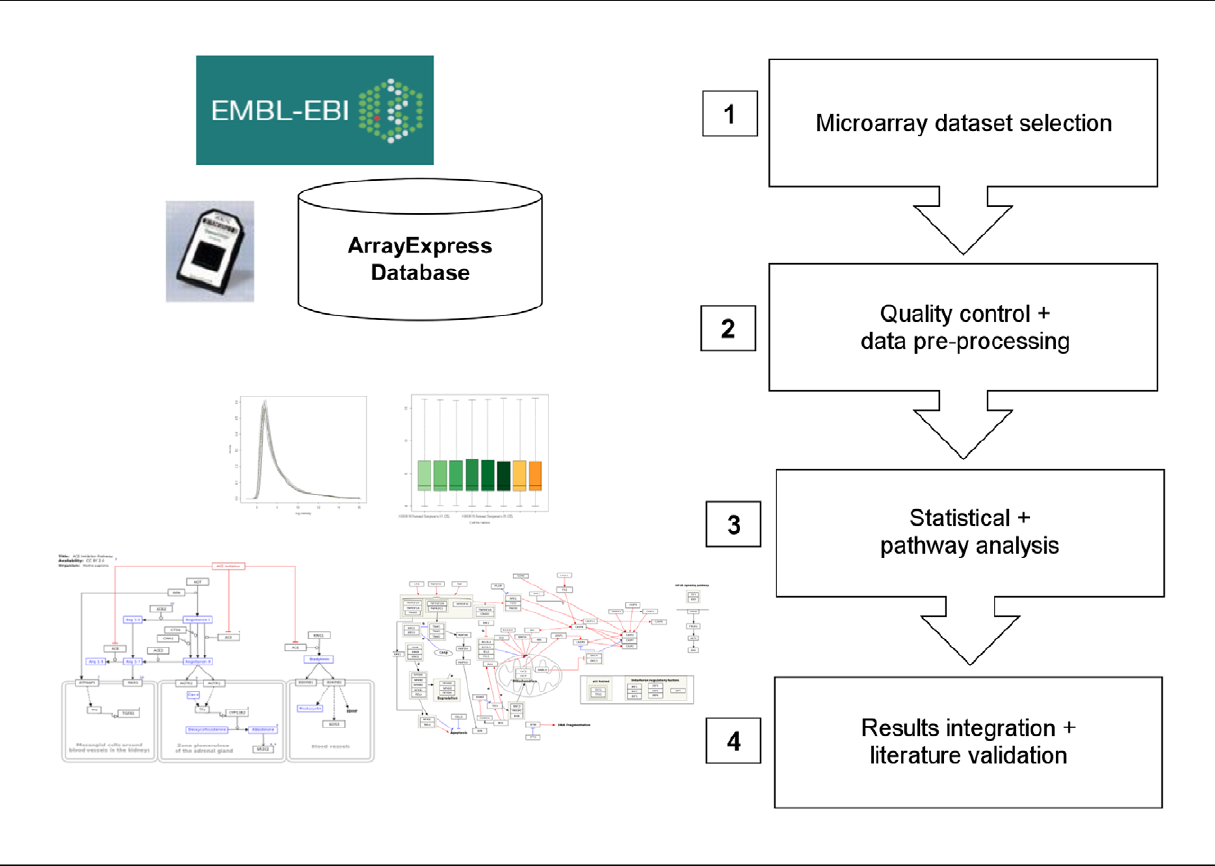
Figure 1. Standardized microarray data analysis workflow. Starting from the publicly available EMBL repository ArrayExpress: 1) Relevant prostate cancer studies were selected and downloaded; 2) Quality control and data pre-processing steps were performed in the R environment. Microarrays with insufficient sample quality, hybridization quality, signal comparability or array correlation were excluded; 3) For each included study, statistical analysis was performed and pathway analysis was run with PathVisio to identify the biological processes involved; 4) Results were then integrated and compared to literature findings.